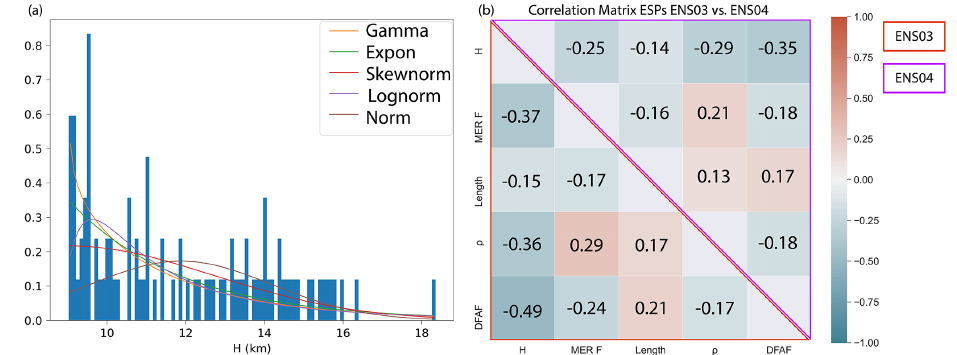
Figure 5. (a) Example of distribution identification for fitting plume height ( H ) from members WLoA of ENS03 and (b) comparison of correlation matrices between ENS03 ESPs in the members WLoA (lower matrix, red triangle) and ESPs posterior pdfs for ENS04 (upper matrix, purple